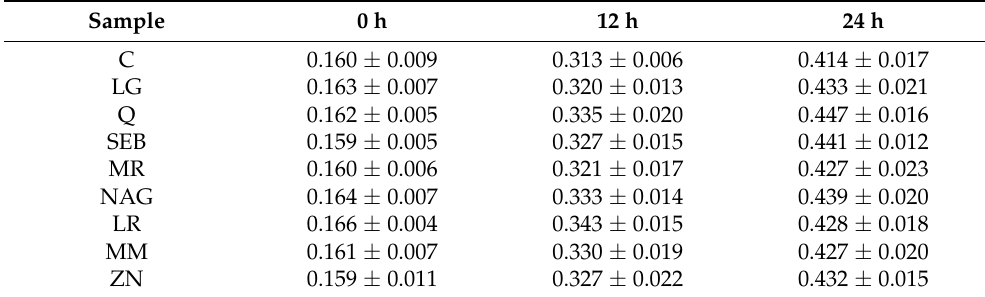
Table 6. Least square means for protease activity (absorbance) of Lactobacillus bulgaricus LB-12 over an incubation period of 24 h as influenced by added